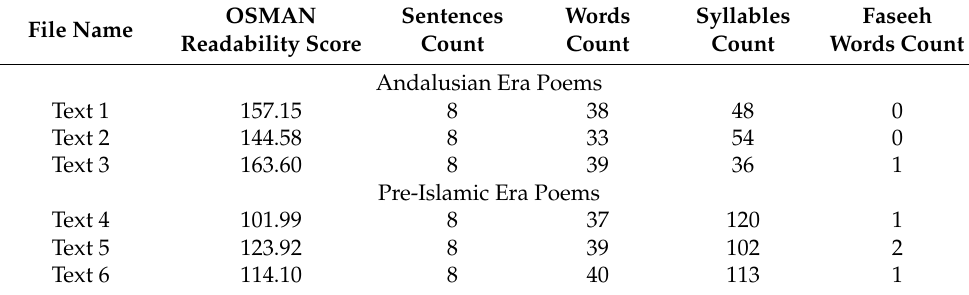
Table 2. Summary of the main features of the texts using